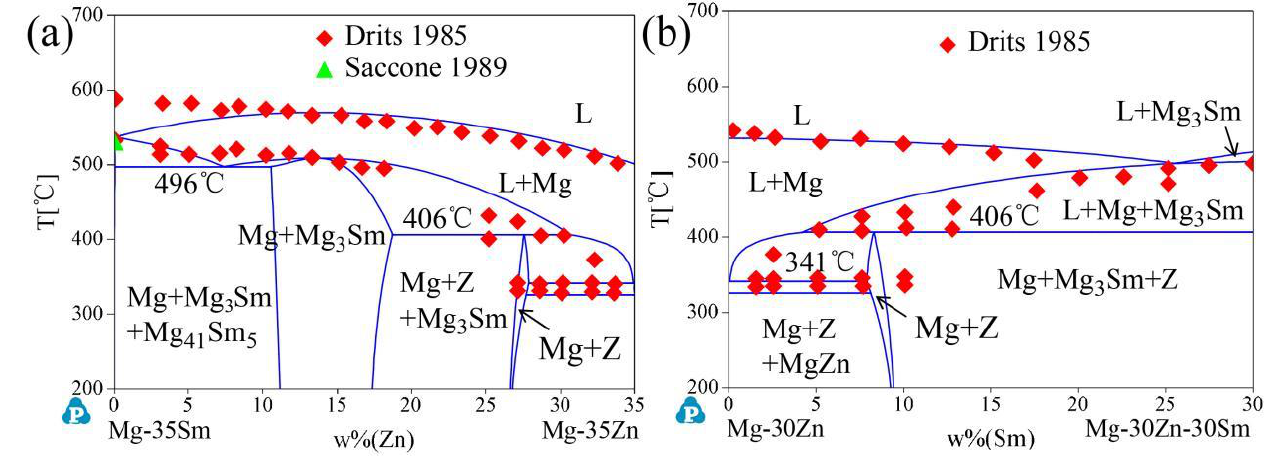
Figure 10. The calculated vertical sections ( a ) from Mg-35Sm to Mg-35Zn (wt.%) and ( b ) from Mg-30Zn to Mg-30Zn-30Sm (wt.%) in comparation with experimental data from [17,33].